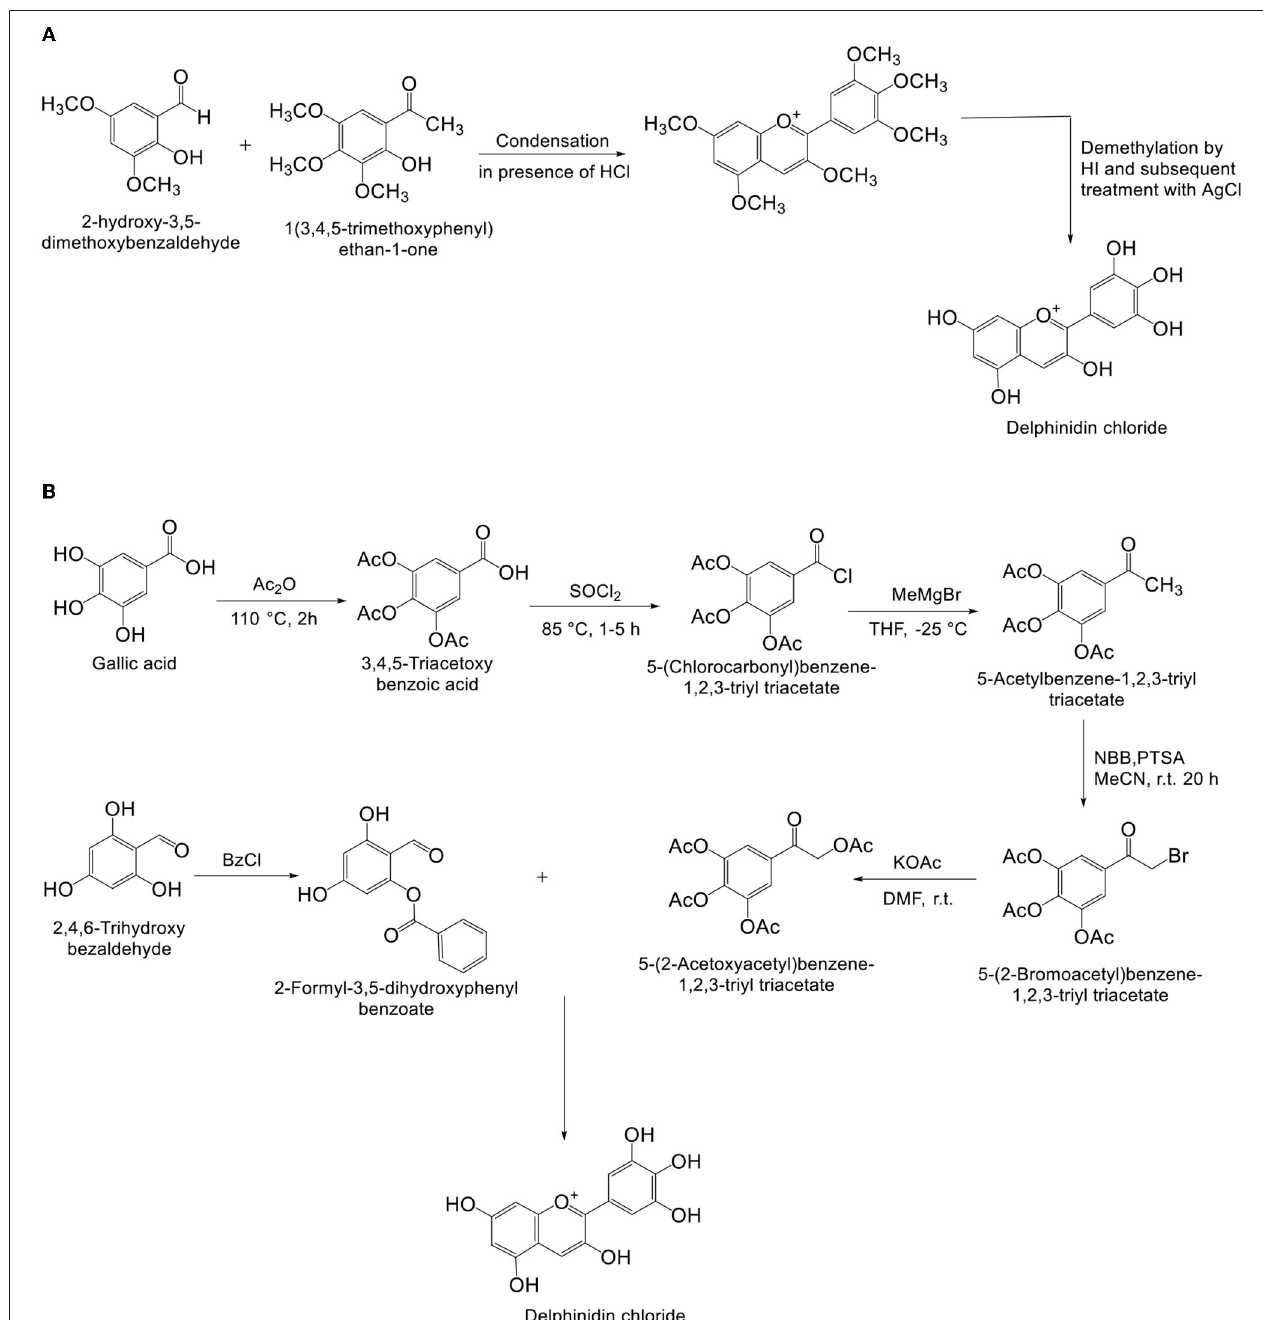
FIGURE 3 | (A,B) Synthesis of delphinidin chloride.